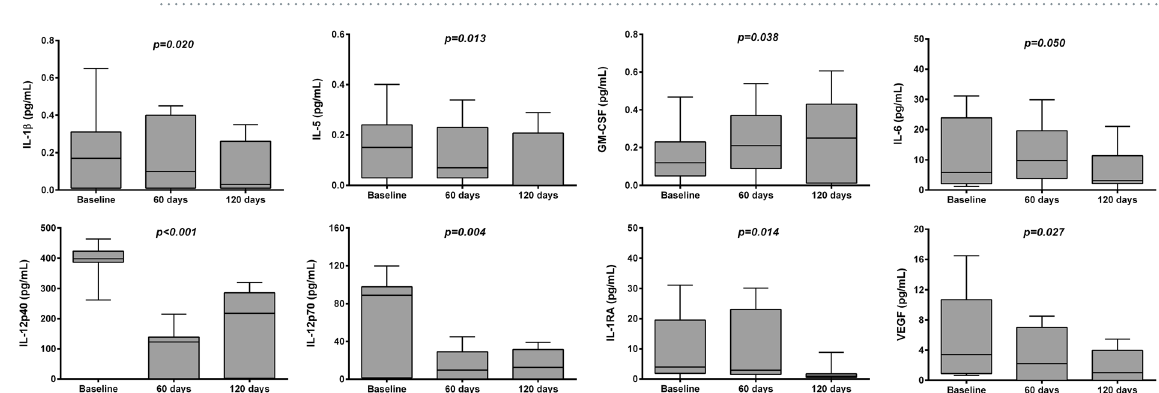
Figure 1. Box-whiskers graphs of Interleukins values at baseline and during the follow-up. Box-whiskers plots show the 25 th and 75 th percentile range (box) with 95% Tukey’s confidence intervals (whiskers) and median values (transverse lines in the box). The p-values in figure are relative to comparison of Interleukins levels among